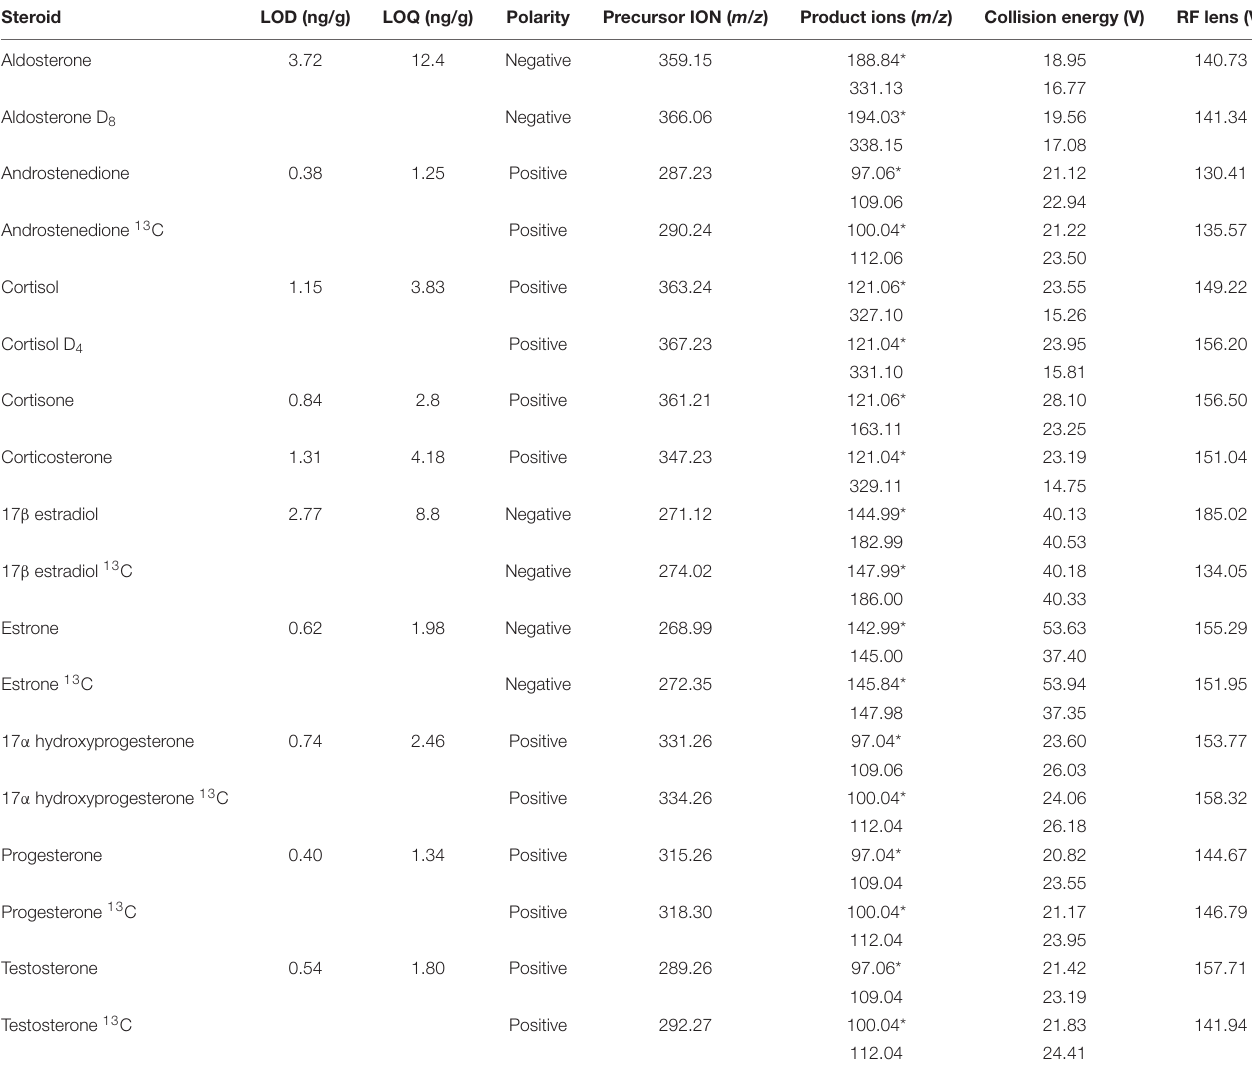
TABLE 2 | Analytical parameters for both isotopically labeled and non-labeled steroid hormones. Steroid LOD (ng/g) LOQ (ng/g) Polarity Precursor ION ( m/z ) Product ions ( m/z ) Collision energy (V) RF lens